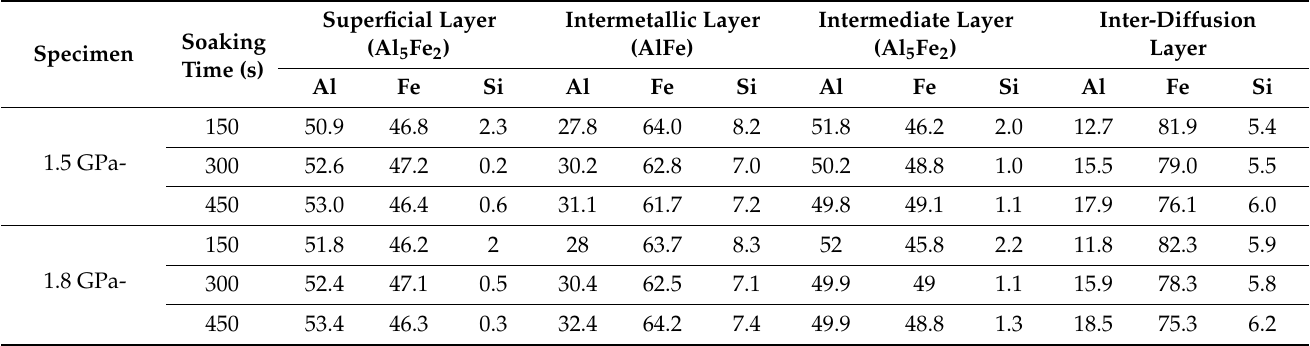
Table 4. Chemical composition of Al-Si coating as a function of austenitizing time at 1203 K in 1.5 GPa grade and 1.8 GPa grade steels.